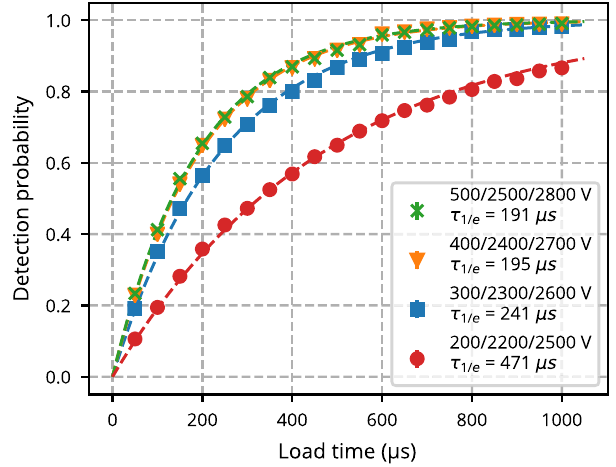
FIG. 7. Calibration of relative MCP detection